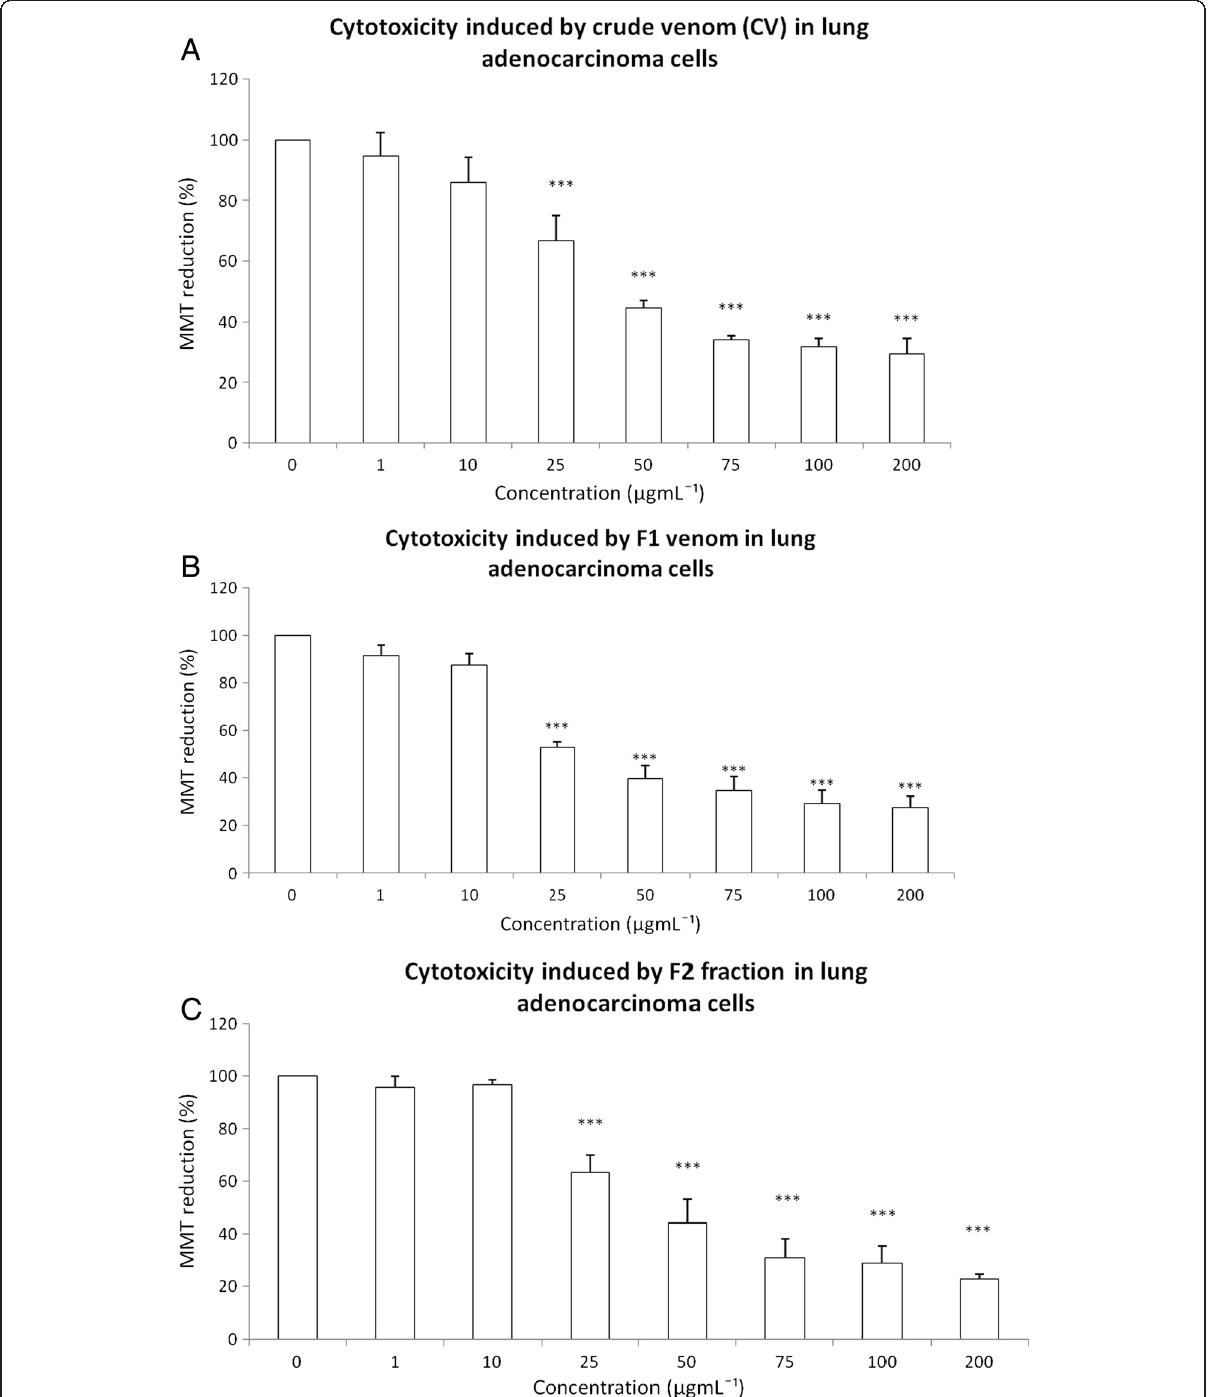
Figure 2 Cytotoxicity induced by CV and the fractions F1 and F2 from B. globulifera at the concentrations 1, 10, 25, 50, 75, 100 and 200 μ gmL -1 on lung adenocarcinoma cell culture. Effect of: ( A ) CV, ( B ) F1 fraction, ( C ) F2 fraction. Graphs show the percentage of MTT reduction. Data are expressed as the mean ± SD of four independent experiments. Significance was defined as *** p < 0.001 (ANOVA, Bonferroni ’ s post test) in comparison with the untreated control values